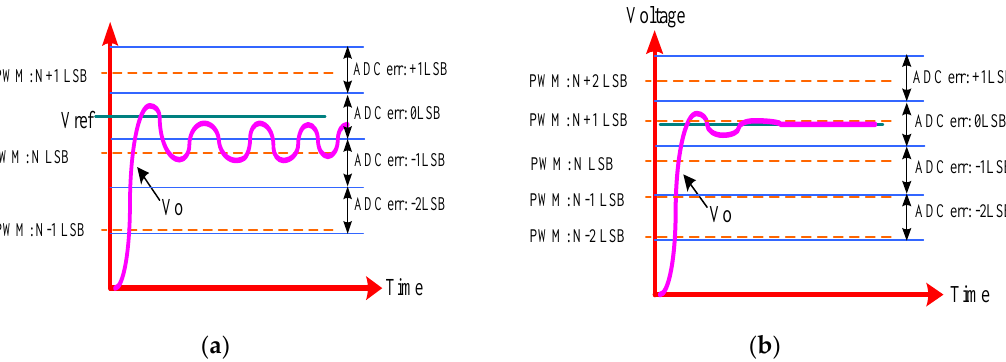
Figure 1. Quantization resolution in a digitally controlled pulse width modulation (PWM): ( a ) with limit cycle oscillation; ( b ) without limit cycle oscillation.